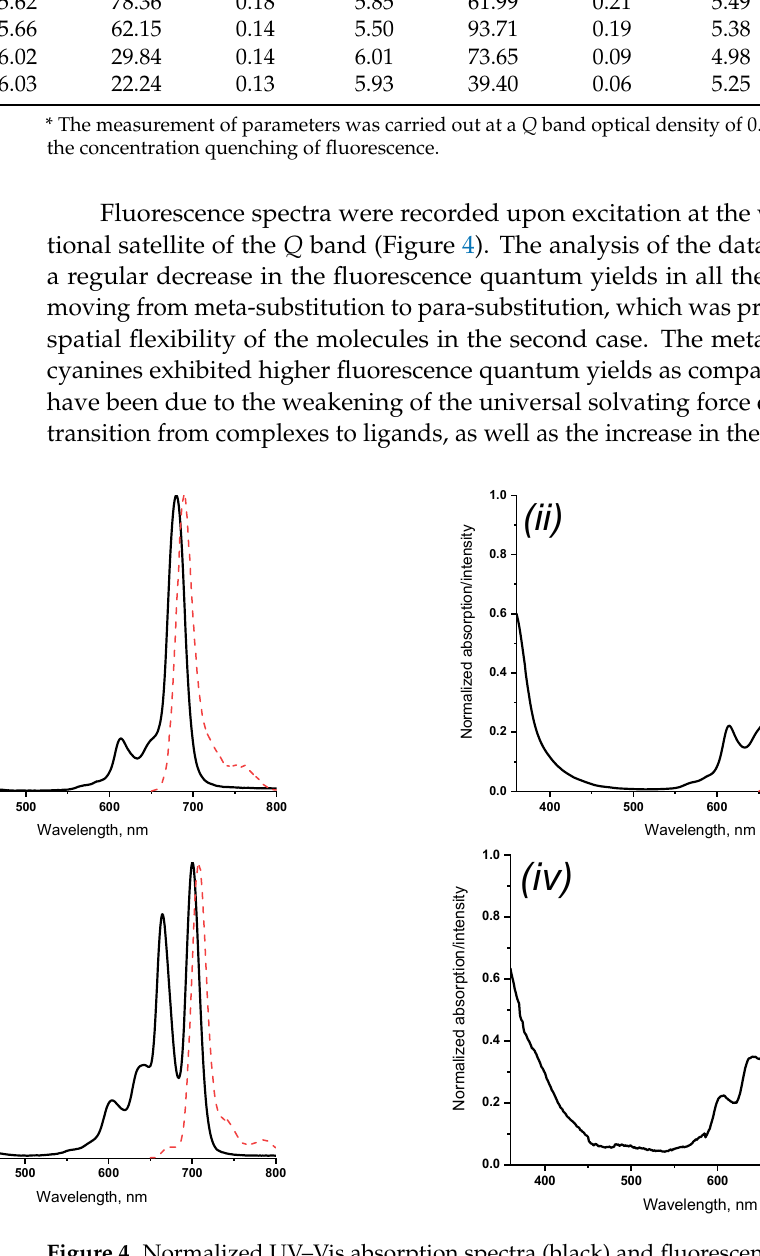
Figure 4. Normalized UV–Vis absorption spectra (black) and fluorescence spectra (dashed red) for compound 4 ( i ), 5 ( ii ), 6 ( iii ), and 7 ( iv ) solutions in CHCl 3 , sample concentration ~10 µ M. For fluores- cence measurements, excitation was performed at the absorption maximum of the vibrational satellite (about 610 nm) (note: spectra in acetone and DMF are provided in the Supplementary Ma- terials). Table 2. Photophysical values of the synthesized metallated and metal-free phthalocyanines ( 4 – 7 ) in CHCl 3 , acetone, and DMF.